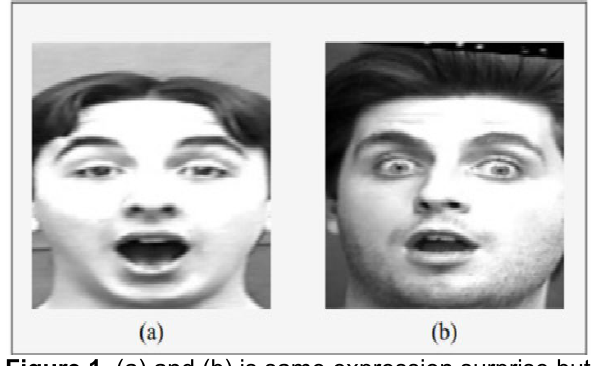
Figure 1. (a) and (b) is same expression surprise but different subject .